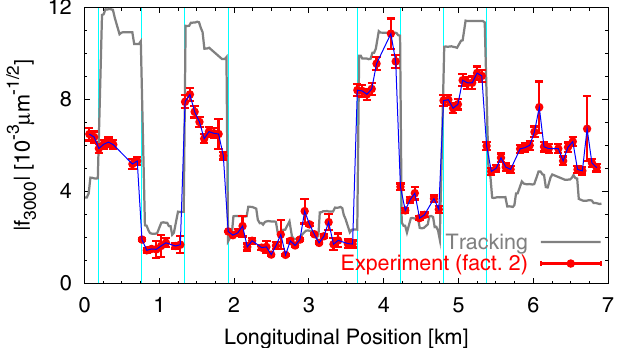
FIG. 14. (Color) Amplitude of the term f versus longitudinal 3000 position from experiment and tracking model for the SPS with extraction sextupoles powered to ( (cid:5) (cid:5) (cid:5) (cid:5) (cid:1) (cid:1) (cid:1) (cid:1) )100 A at 80 GeV. The blue line is used to connect the experimental points. The vertical lines denote the position of the extraction sextu- poles.